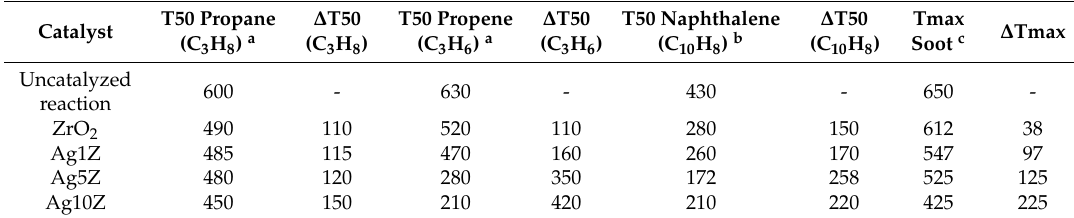
Table 3. Catalytic activity of ZrO 2 and the three prepared AgxZ catalysts, for the different oxidation reactions